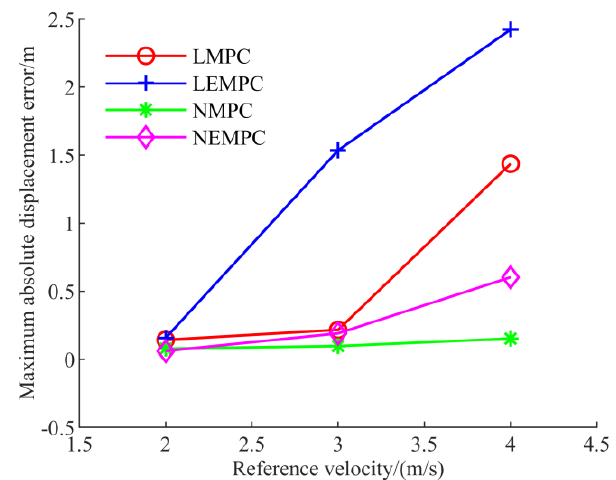
Figure 19. The trend of the maximum absolute displacement error.